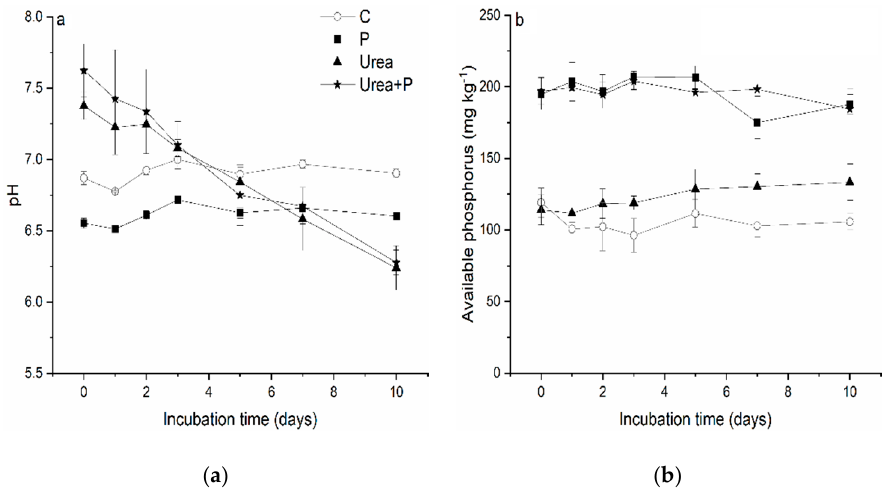
Figure 1. pH ( a ) and available phosphorus ( b ) in soil amended with and without urea, P, urea + P during the incubation study. Legends correspond to the amendment of urea N (urea, 0.20 g N kg − 1 soil), monopotassium phosphate (P, 0.087 g P kg − 1 soil), urea N and monopotassium phosphate (urea + P, 0.20 g N kg − 1 soil + 0.087 g P kg − 1 soil). The soil without N and P addition was used as the control (C, control). Three soil samples in each treatment were taken after 0, 1, 2, 3, 5, 7 and 10 days of incubation. Data in the figure represent means ± standard deviations ( n = 3).